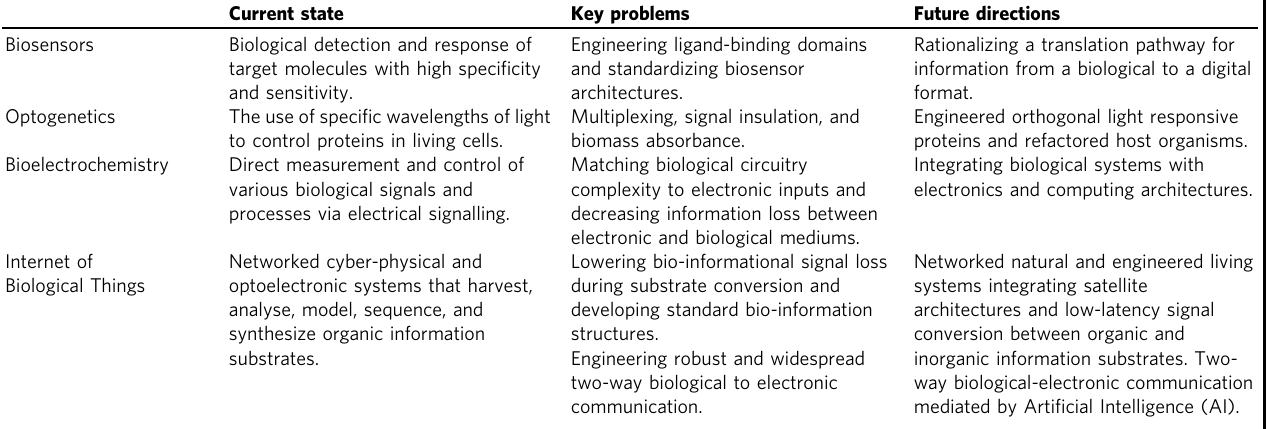
Table 1 Development prospects for bio-informational